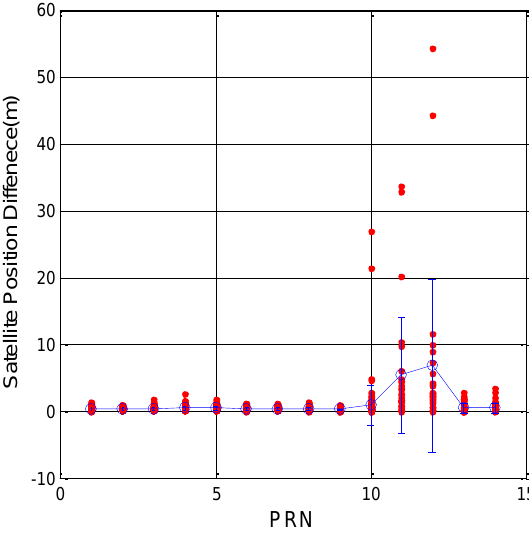
Figure 4. BDS DQA1: Satellite position difference between new and original